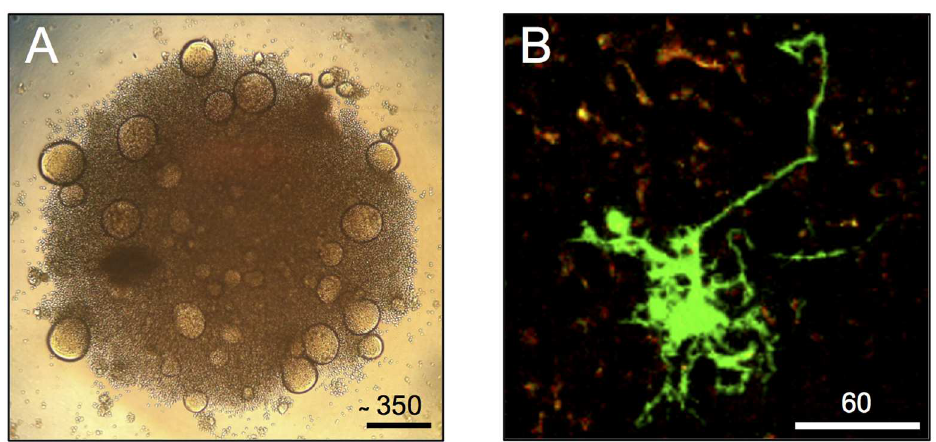
Fig 1. Out with the old, in with the new. (A) SupT1 T cells were incubatedwith HIV-1 in a 96-wellplate. At two days post-infection, cells were visualizedwith a light microscopeat 10x magnification. Scale bars are in μ m. Photo taken with the iPhone4. (B) BLT humanizedNOD-SCID mice were infected with HIV-1-GFP via footpad injection. Multiphoton intravital microscopy of the drainingpopliteallymph node was performed at six days post-infection. This micrographof HIV-infectedcells (green)is a maximum intensity projectionof 11 z- stacks, spaced 4 μ m apart. Red-orangesignal corresponds to autofluorescent tissue structures. This image is a generousgift from Thomas Murooka and Thorsten